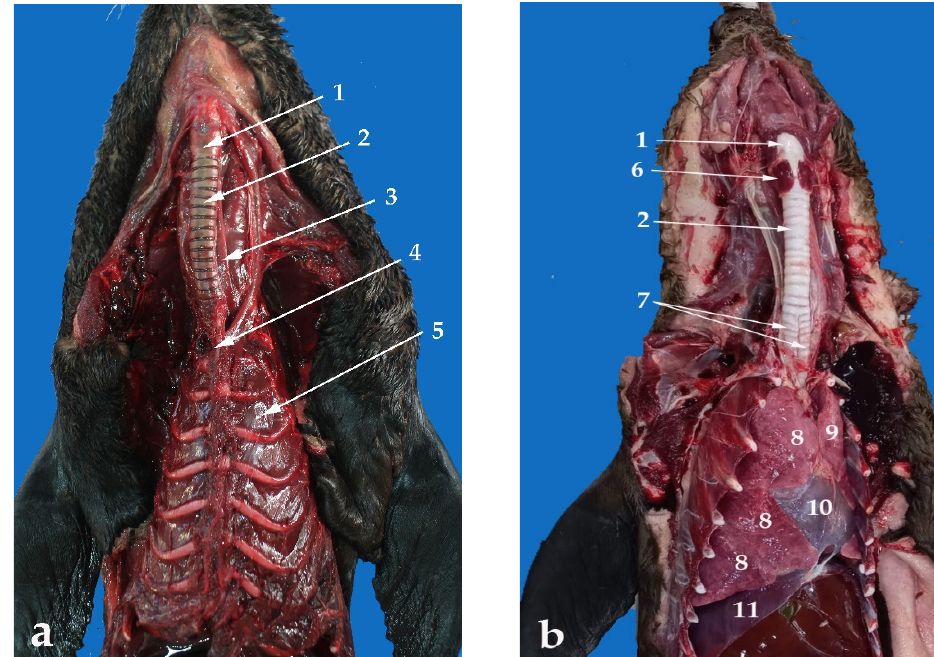
Figure 6. Ventral view of the neck and the thorax ( a ) and the neck and thoracic and abdominal cavities ( b ): (1) larynx; (2) trachea; (3) esophagus; (4) sternal manubrium; (5) thorax; (6) thyroid gland; (7) main bronchi; (8) right lung; (9) left lung; (10) heart; (11) diaphragm.